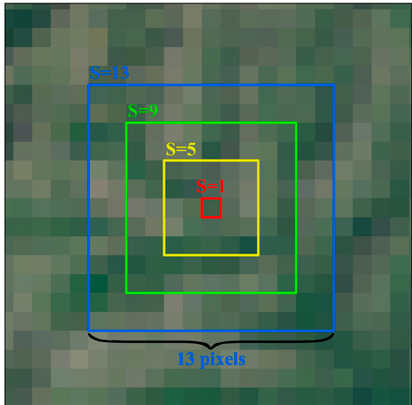
Figure 2. An example of moving windows for the extraction of adjacent region feature at different scales of the focus pixel. (Note that this is just a schematic, and not all the feature extraction windows are shown here).